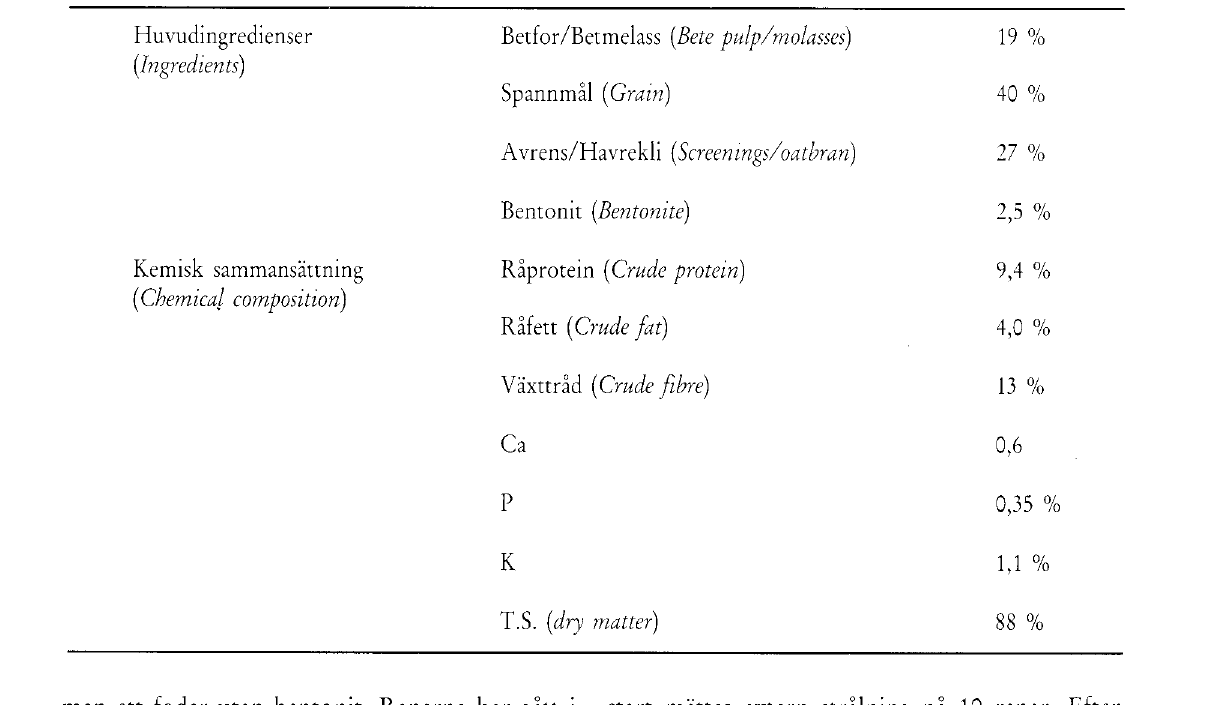
Table 2. Composition of pelleted reindeer feed used when feeding reindeer to lower their radiocaesium levels. Huvudingredienser Betfor/Betmelass (Bete pulp/molasses)